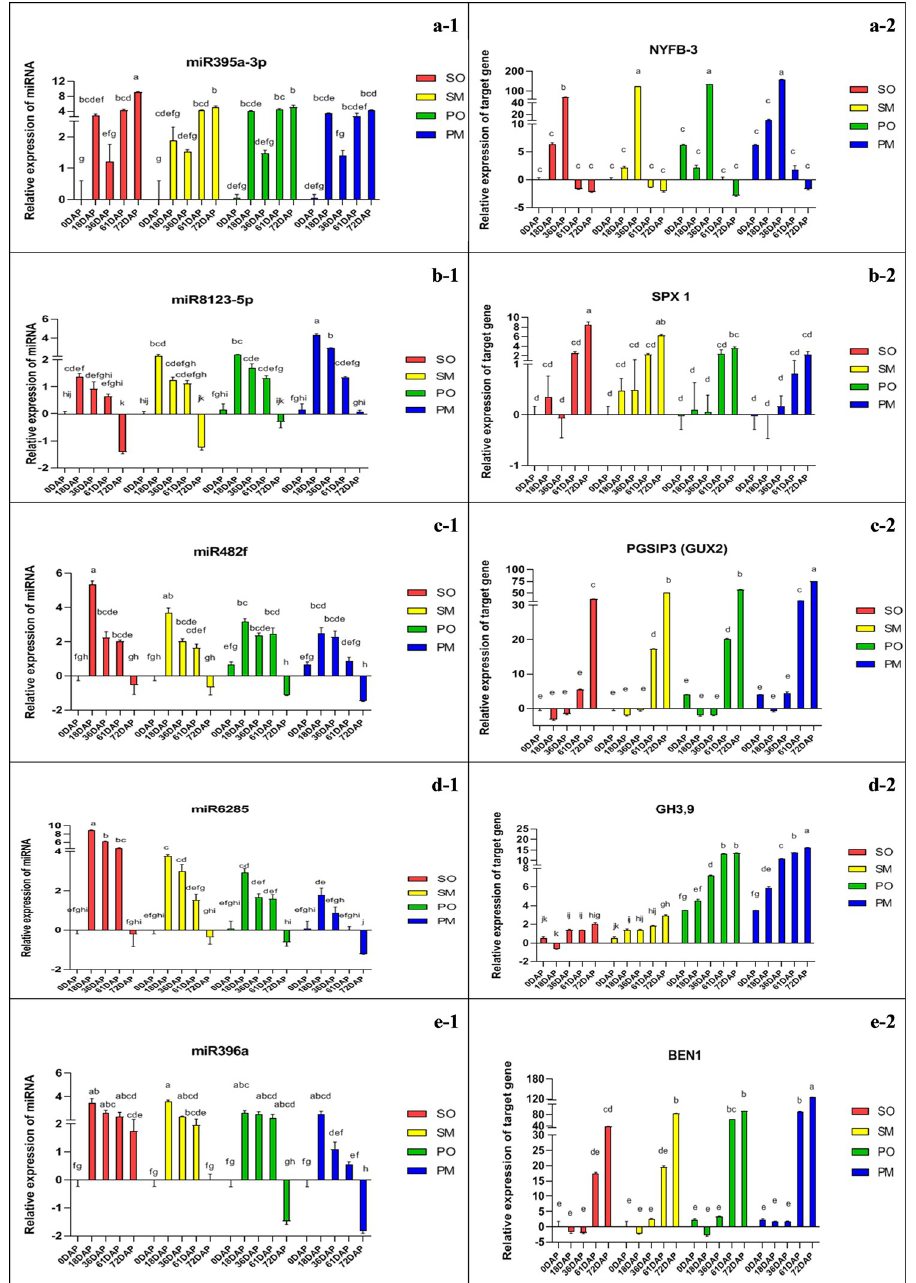
Fig 7. qPCR analysis of kernel size miRNAs and their targets expression profiles in developing kernel of SM, SO, PM and PO almond crosses. Values represent arithmetic mean of two replicates ± SE (standard error). Different lowercase letters indicate significant differences at p < 0.05 in the Duncan’s multiple range